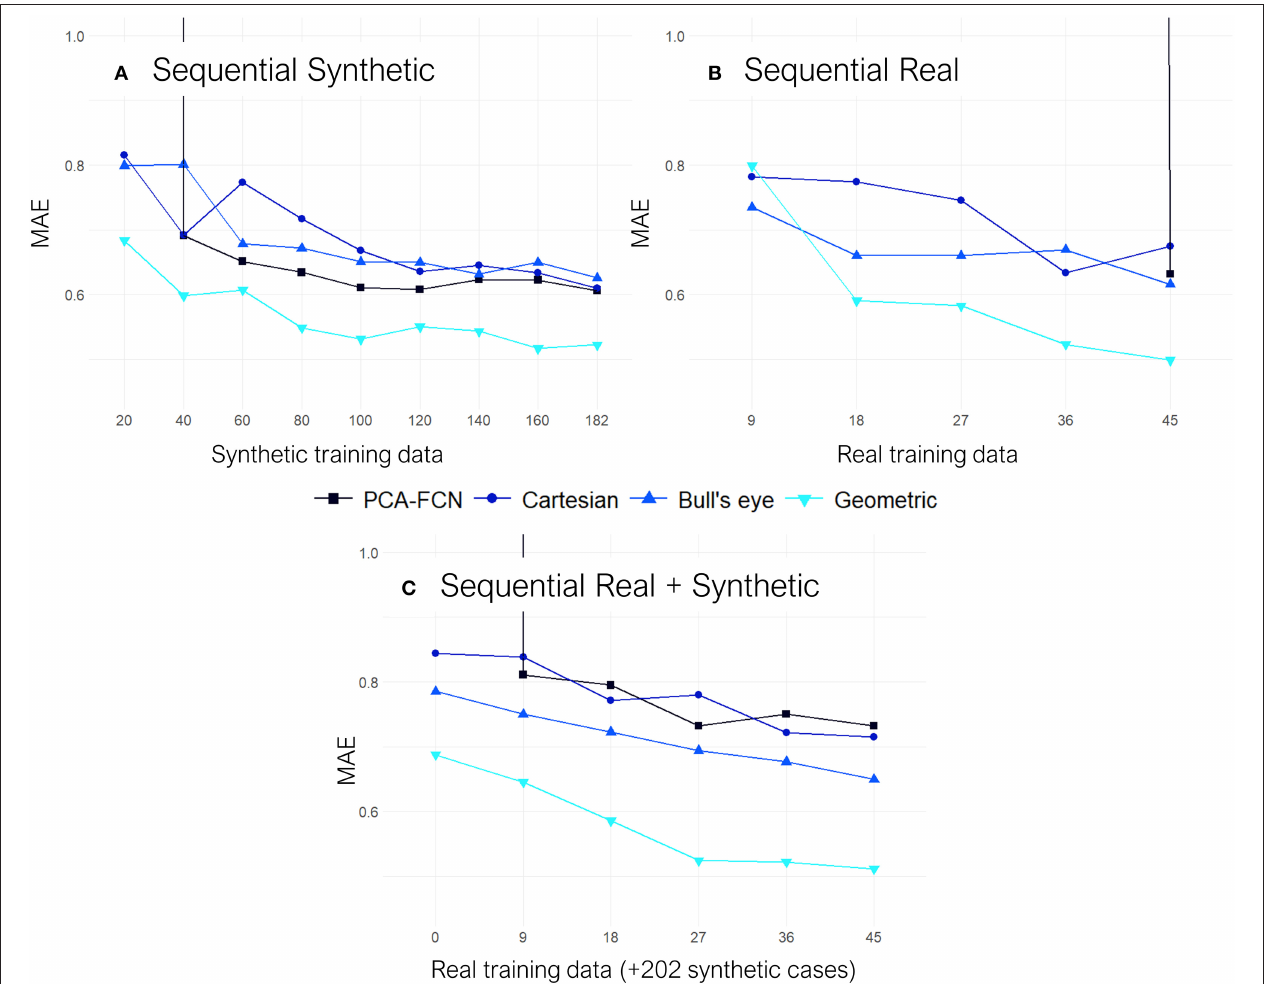
FIGURE 6 | All results are shown on terms of the mean absolute error (MAE). (A) Results from the “Sequential Synthetic” experiment in which only the synthetic data was employed for training. (B) Results from the “Sequential Real” experiment which only trained and tested on the real cases. (C) Results from the “Sequential Real + Synthetic” test, in which all the synthetic geometries were employed as the training baseline and subsequently, batches of real data were sequentially added on